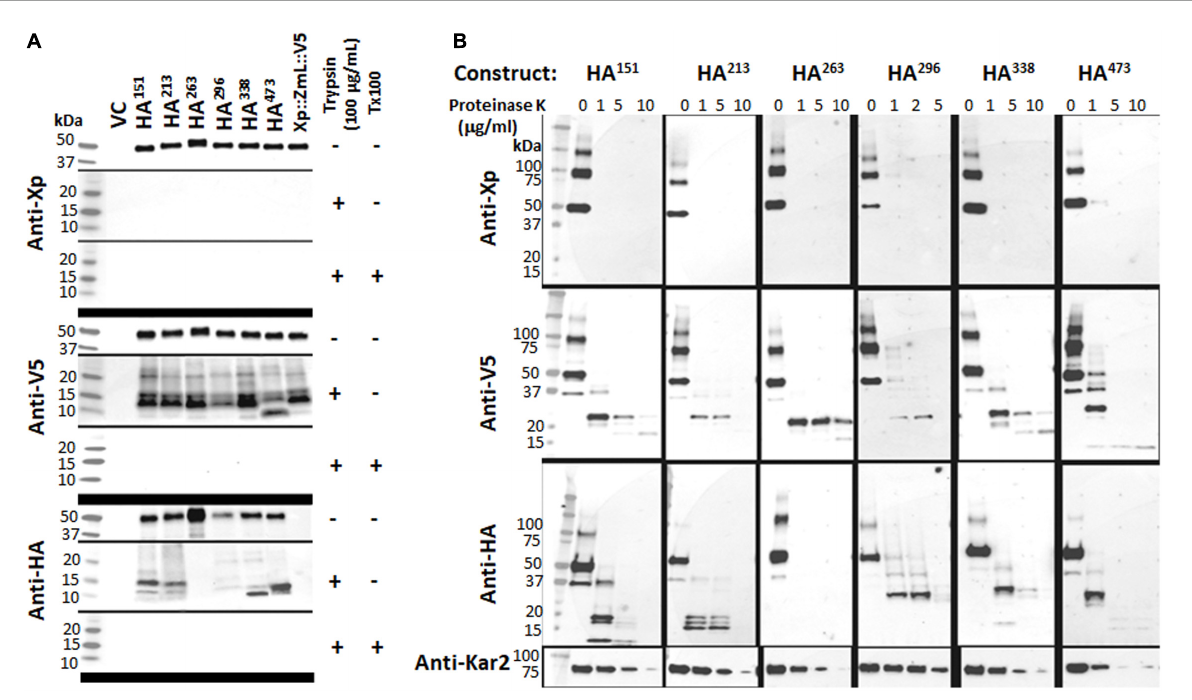
FIGURE4 (A) The addition of trypsin alone resulted in the total disappearance of the Xpress (Xp) tag and the appearance of conserved fragments containing the V5 tag; when both trypsin and triton X-100 were added the V5 signal was also lost. (B) The addition of proteinase K produced similar results. Combined, the data indicate the N-terminus of each tagged DGAT1 is located in the cytoplasm and the C-terminus is located in the lumen. In contrast to the N- and C-terminal tags, the susceptibility of the internal HA tags to protease was dependent on the construct. The addition of trypsin alone or proteinase K resulted in the loss of the HA signal from Xp::ZmL-HA 263 ::V5 (HA 263 ), whereas HA 151 and HA 213 all had similar conserved fragments while HA 296 , HA 338 , and HA 473 had a different set of conserved fragments; no HA was detected from any construct after the addition of both trypsin and triton X-100. Thus, residues 151–213 appear to belong to the same luminal loop, residue 263 is located in the cytoplasm, and from residue 296 to the C-terminus are located between the integral membrane to the lumen. The protease protection assays for HA 251 have not been considered as no recombinant protein was detected. The yeast KAR2 protein is most homologous to mammalian BiP/GRP78 and was detected in this study as a control for the ER-localized protein. VC, vector